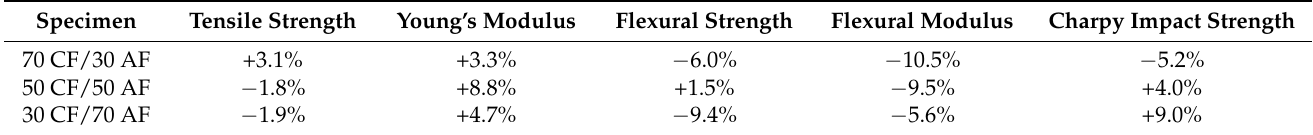
Table 3. Experimentally determined hybrid effects as a function of mixing